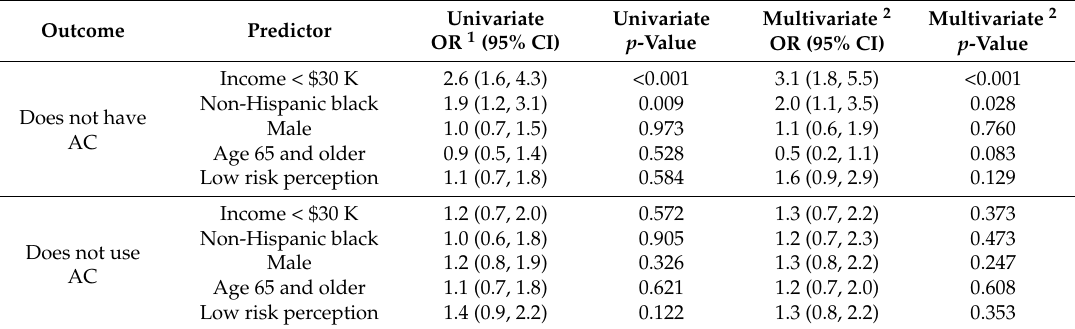
Univariate Univariate Multivariate 2 Multivariate 2 p -Value OR 1 (95% CI) p -Value OR (95% CI)